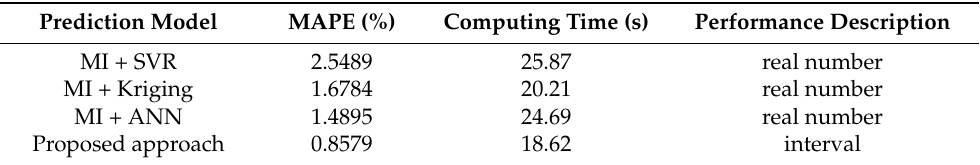
Table 4. Comparison between the proposed approach and the other approaches using the same experimental